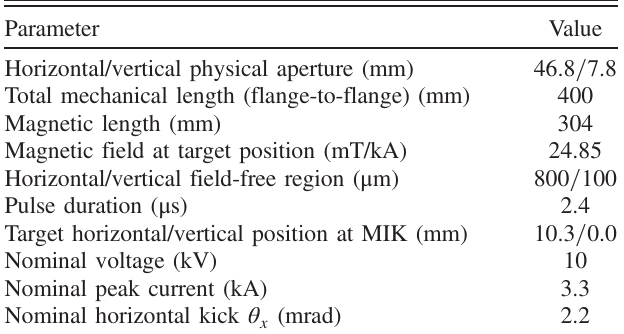
TABLE V. Main design specifications of the